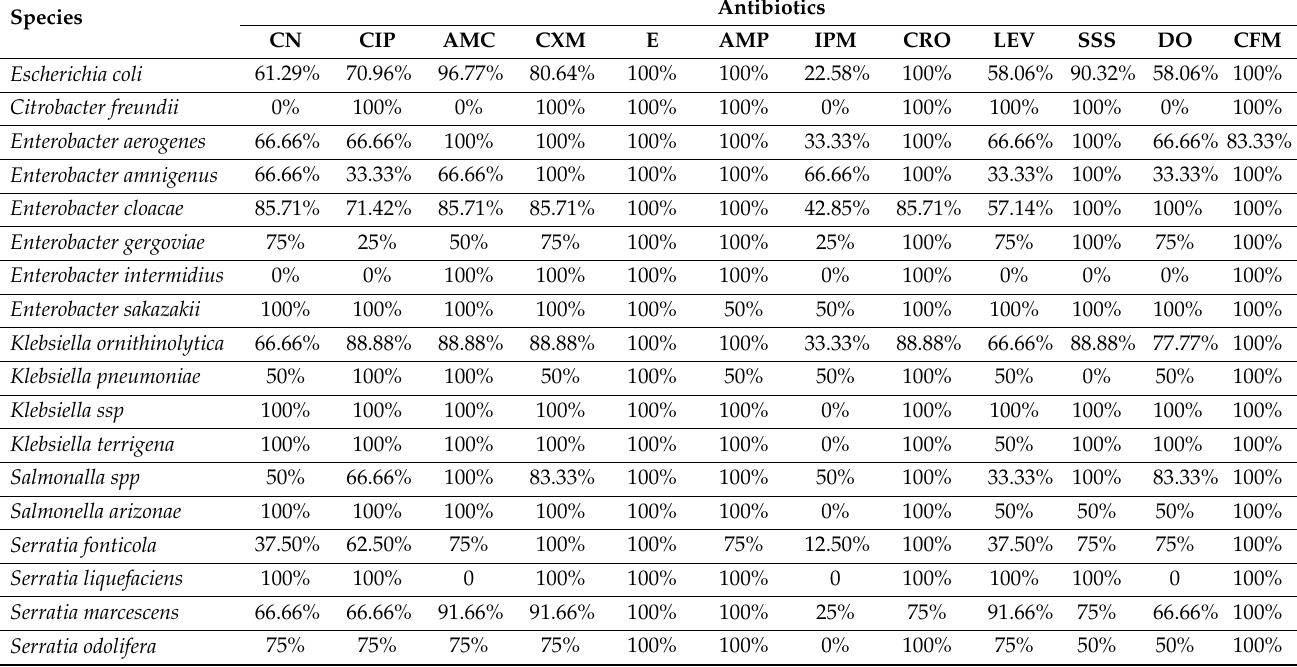
Figure 2. Resistance profile of isolated Enterobacteriaceae strains to antibiotics. CN: gentamicin, CIP: ciprofloxacin, AMC: amoxicillin/clavulanic acid, CXM: cefuroxime, E: erythromycin, AMP: ampicil- lin, IPM: imipenem, CRO: ceftriaxone, LEV: levofloxacin, SSS: sulfonamide, DO: doxycycline, CFM: cefixime. Table 3. Resistance to antibiotics by isolated species of Enterobacteriaceae .